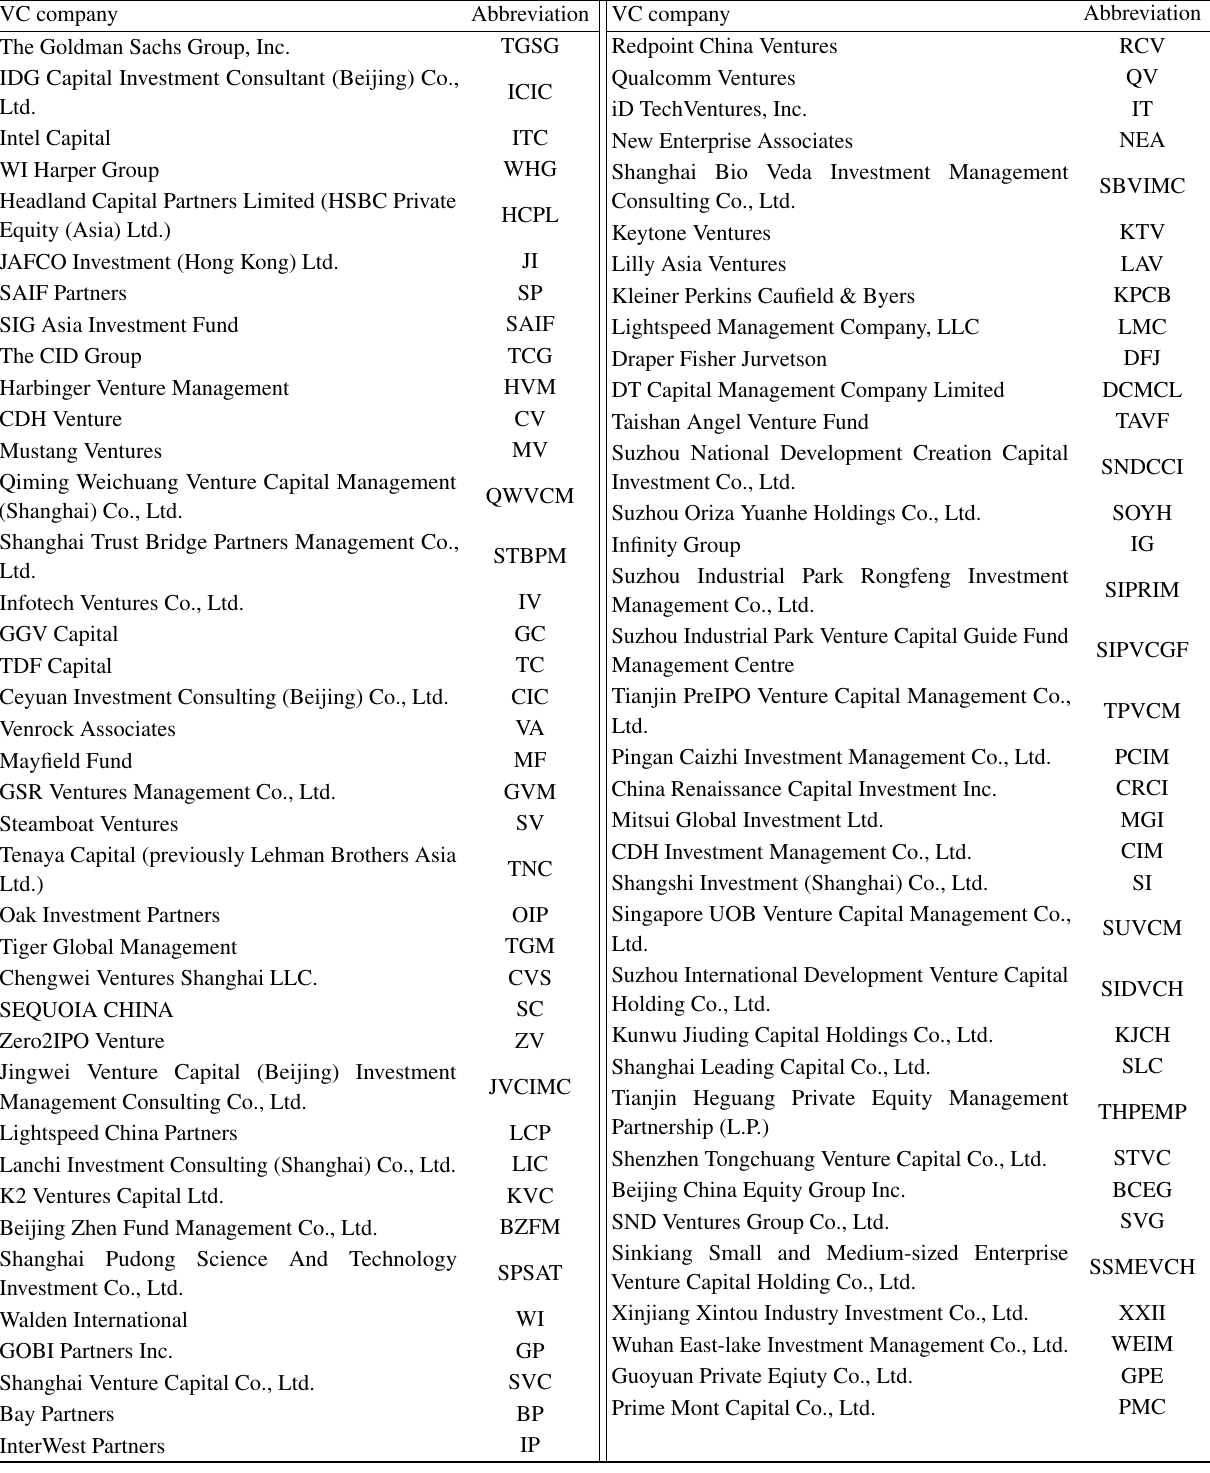
Table 14 (cid:4)(cid:4)(cid:4)(cid:4)(cid:4) Table A1 Detailed list of abbreviations and English names of VC